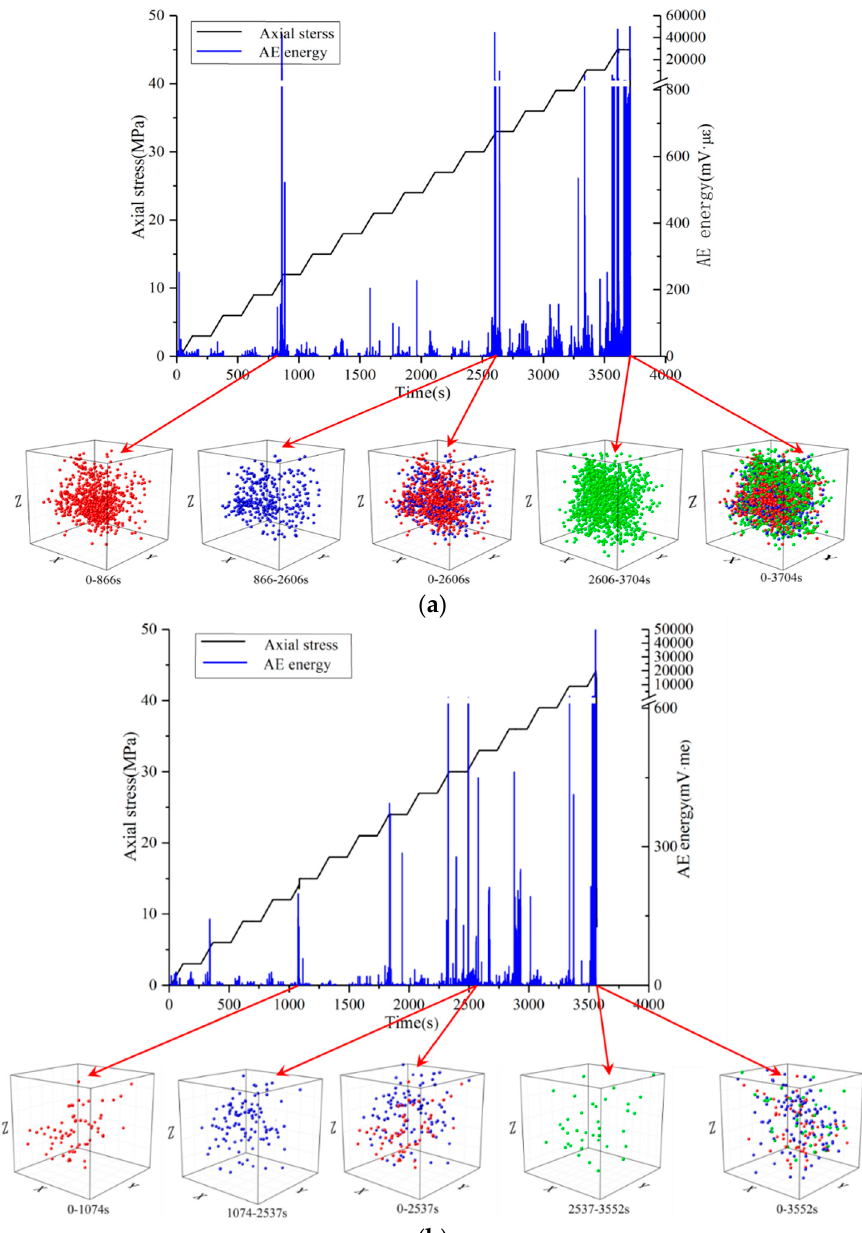
Figure 4. Time-space response of AE energy during damage of granite samples. ( a ) intact sample; ( b ) holey sample.